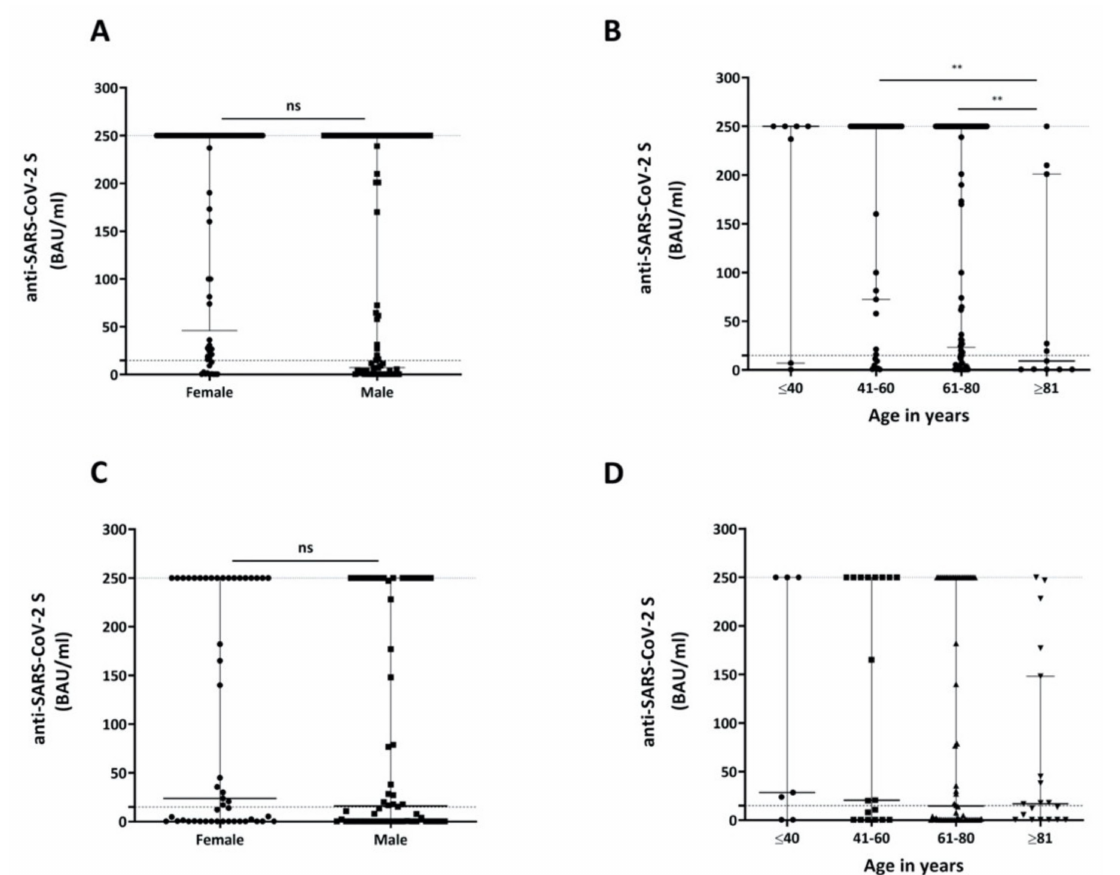
Figure 2. Comparison of antibody levels based on gender or age. ( A ) Comparison of antibody levels after COVID-19 vaccination in solid tumor patients stratified by gender. ( B ) Comparison of different age groups of solid tumor patients with respect to antibody formation upon COVID-19 vaccination. ( C ) Comparison of antibody levels after COVID-19 vaccination in hematologic patients stratified by gender. ( D ) Comparison of different age groups of hematologic therapies with respect to antibody formation upon COVID-19 vaccination. Threshold (lower dotted line) indicates ≥ 15 BAU/mL; the upper dotted line shows the upper limit of the assay (250.01). Displayed are median values and 95% CI of BAU/mL values (upper and lower ends of error bars). BAU: Binding Antibody Units, ns: not significant; ** p <